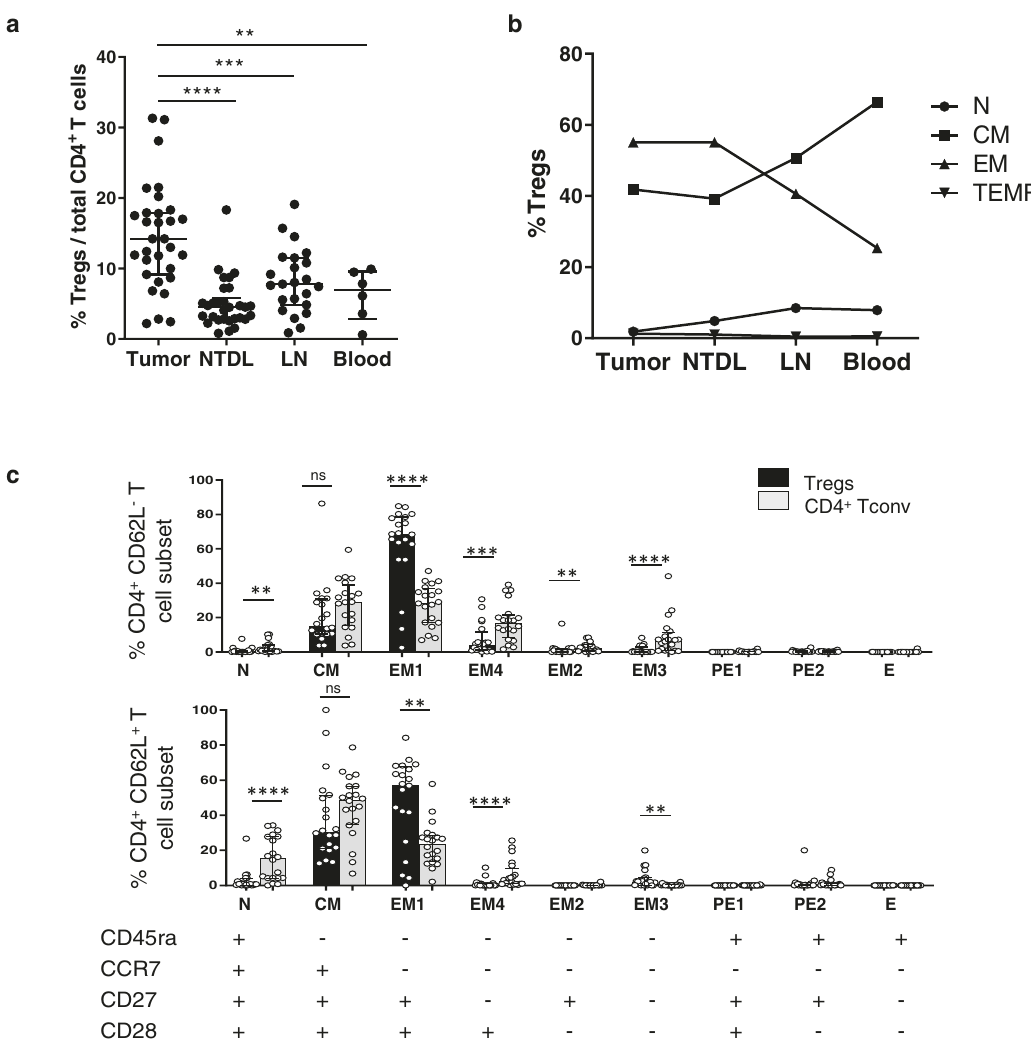
Fig. 3 Stages of differentiation of Tregs according to their anatomical location. a Frequency of CD3 + CD25 bright FoxP3 bright cells among total CD4 + T cells in tumor ( n = 31), non-tumoral distant lung (NTDL, n = 30), lymph nodes (LN, n = 23), and peripheral blood ( n = 6) of NSCLC patients. Data are represented as median with interquartile range. Wilcoxon – Mann – Whitney U test; ** P = 0.0045, *** P = 0.0006, **** P < 0.0001. b Representation of the main four stages of differentiation of Tregs in the different anatomical sites ( n = 21 patients). c Stages of differentiation of both CD3 + CD25 bright FoxP3 bright Tregs (in black) and CD4 + Tconv (in gray) according to the differential expression of CD45ra, CCR7, CD27, and CD28 in TLS (CD62L + , top panel) and non-TLS (CD62L - , bottom panel) areas ( n = 21 patients). Data are represented as median with interquartile range. Wilcoxon – Mann – Whitney U test; ** P < 0.01, *** P < 0.001, **** P < 0.0001. CM, central-memory T cells, E exhausted T cells, EM effector-memory T cells, LN lymph node, N naïve cells, ns non-signi fi cant, NTDL non-tumoral distant lung, TEMRA terminally differentiated effector-memory CD45ra + T cell, TLS tertiary lymphoid